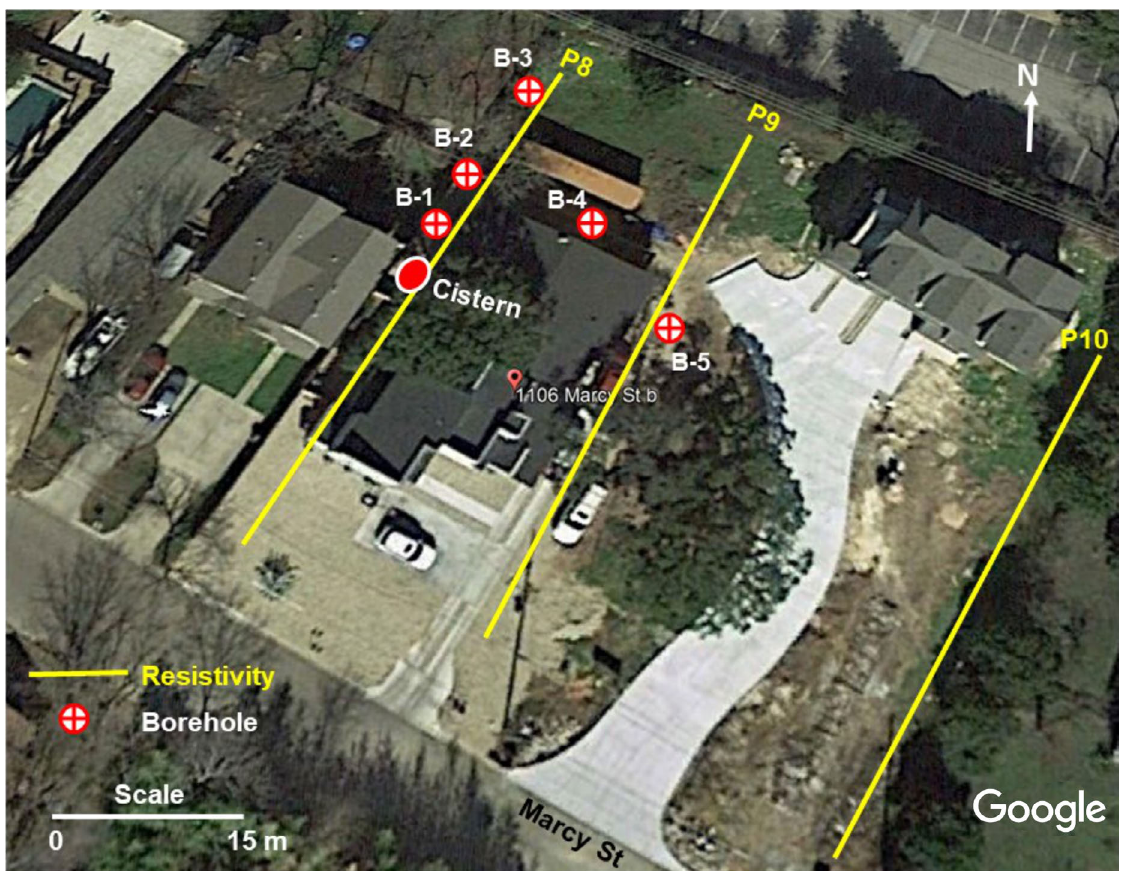
Figure 11: Site map of the house showing locations of resistivity profiles (P8 through P10) and the recently uncovered cistern along profile P8. Five borings (B-1 through B-5) were obtained during the investigation of the foundation of the residence. Note that the length of the profiles were restricted by a road and a fence in the southern and northern sections of the study area, respectively. ©2019 Google LLC, used with permission. Google and the Google logo are registered trademarks of Google LLC.